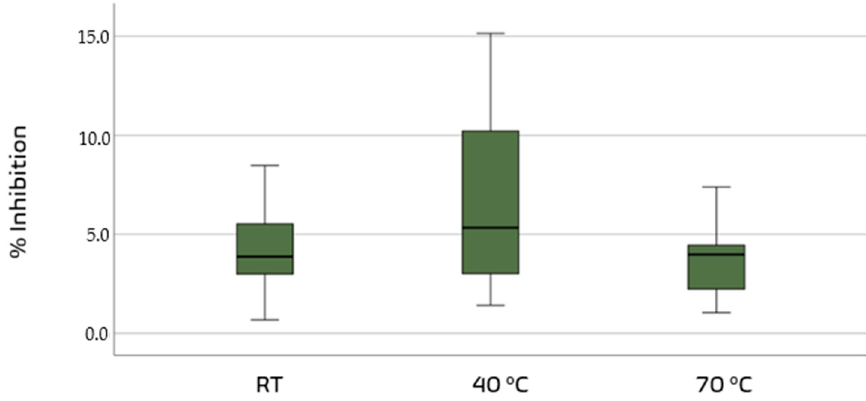
Figure 2. Boxplots for the median values of the inhibition of the DPPH radical (%) in the presence of extracts obtained at different temperatures.